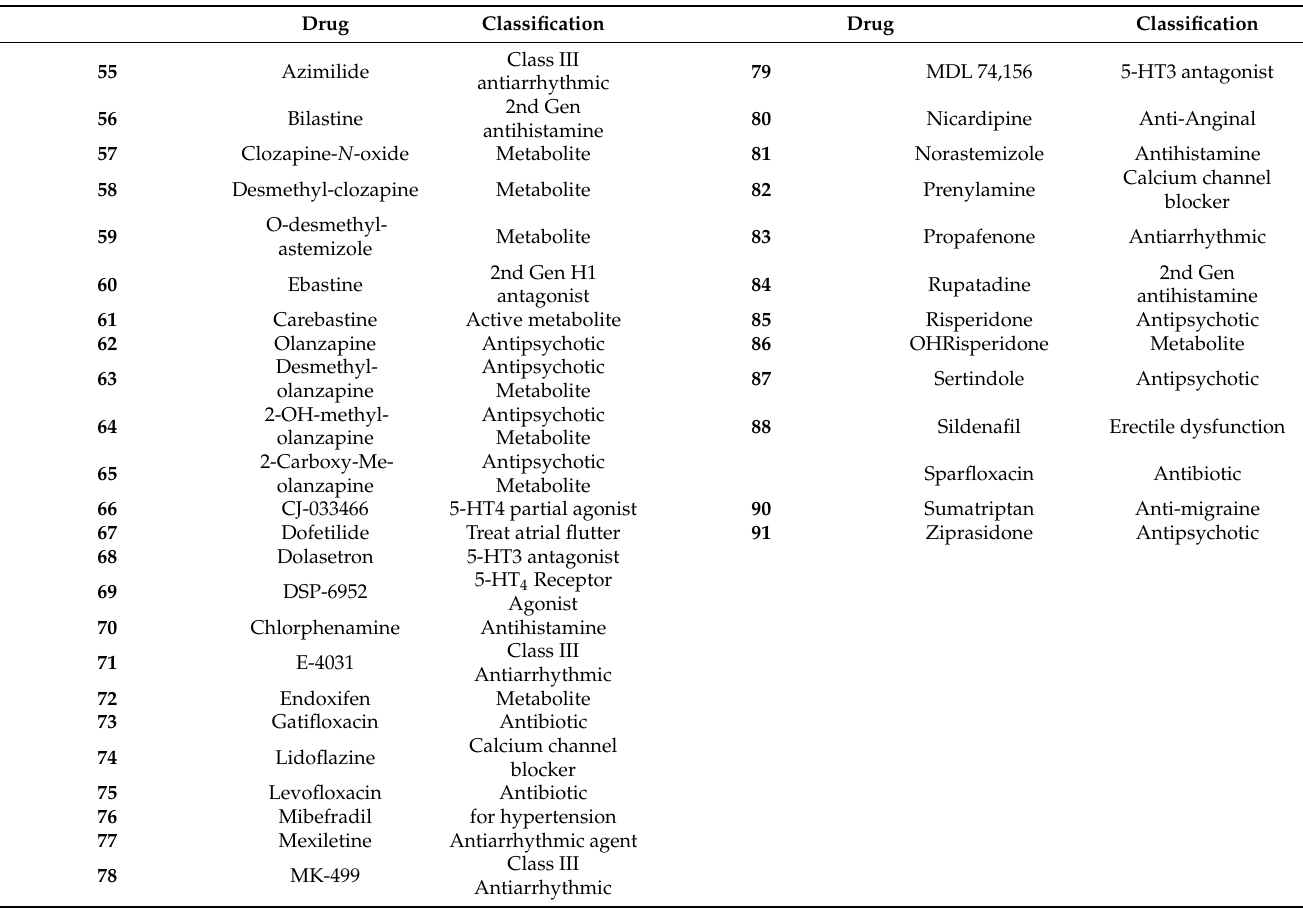
Table 3. Second set of compounds that may prolong QT and/or induce Torsades de Pointes.